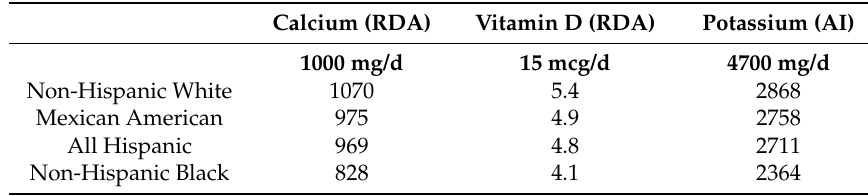
Table 2. Nutrient intake from food: mean amounts consumed per individual, by race/ethnicity, age 19–50